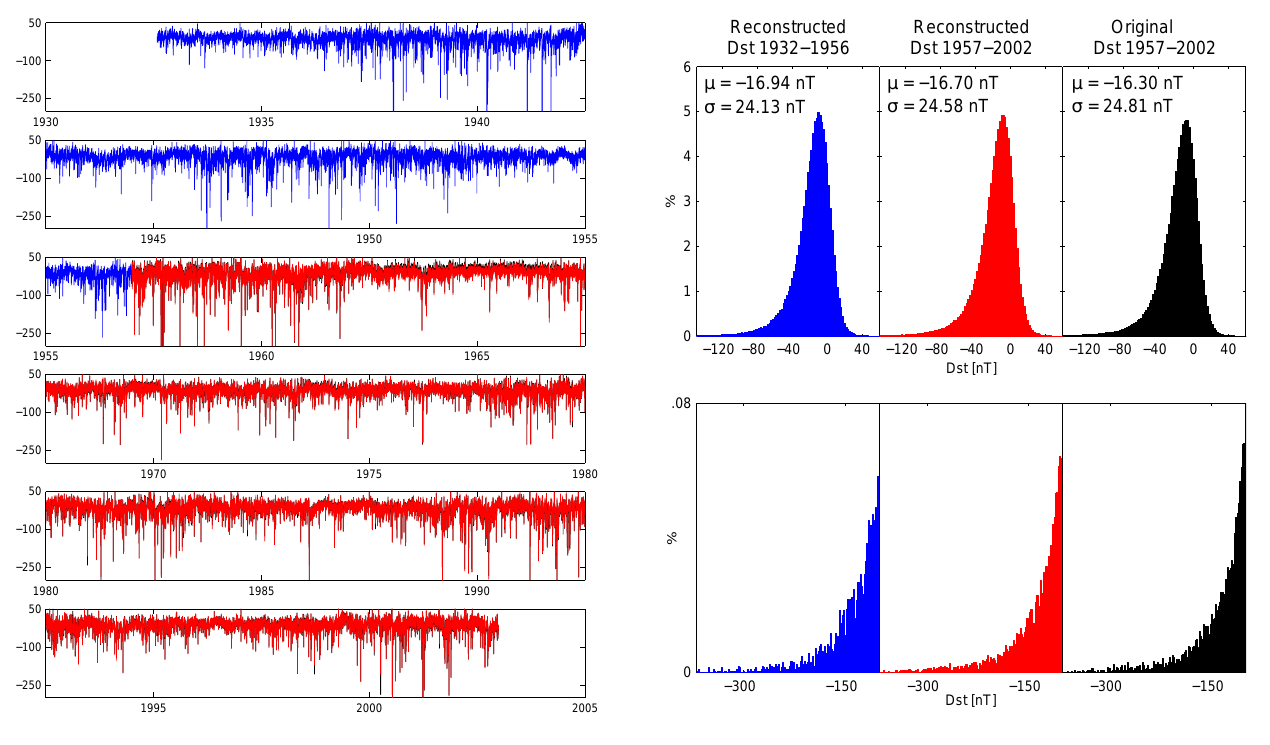
Fig. 3. Histograms of the reconstructed D st in 1932–1956 (blue), in 1957–2002 (red) and of the original D st 1957–2002 (black). Top panel depicts the values for D st > –150nT, bottom panel for D st < –100nT. Only gapless data were